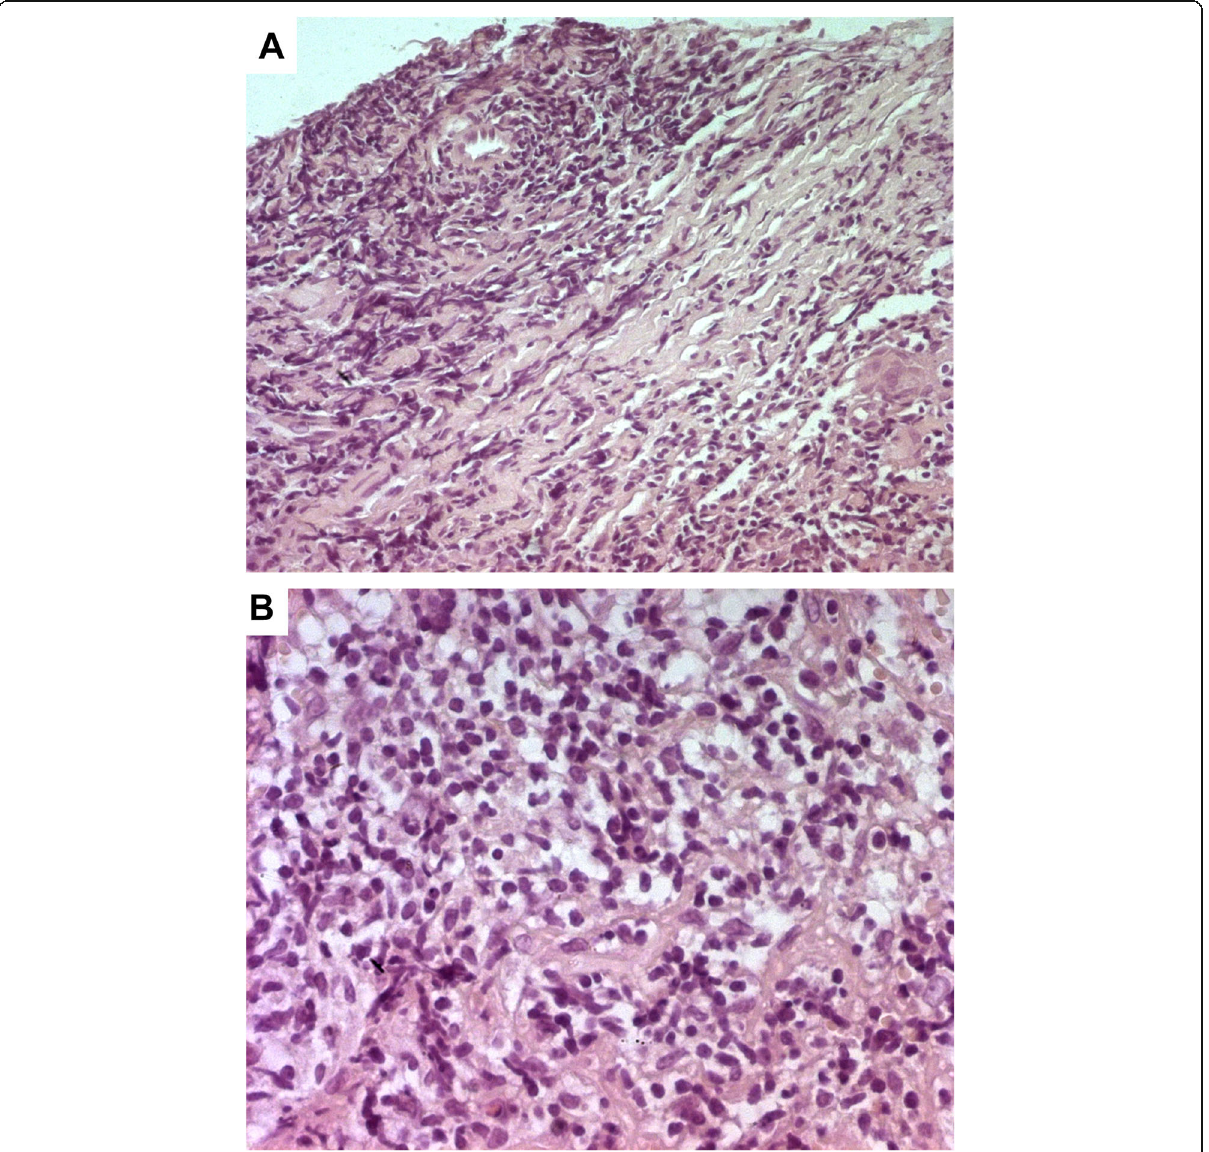
Fig. 1 Histopathological features of extranodal NK/T-cell lymphoma. Diffuse malignant lymphoid proliferation made of pleomorphic tumoral cells with atypical and dense nuclei, and mitotic figures ( a original magnification, × 200; b original magnification, ×